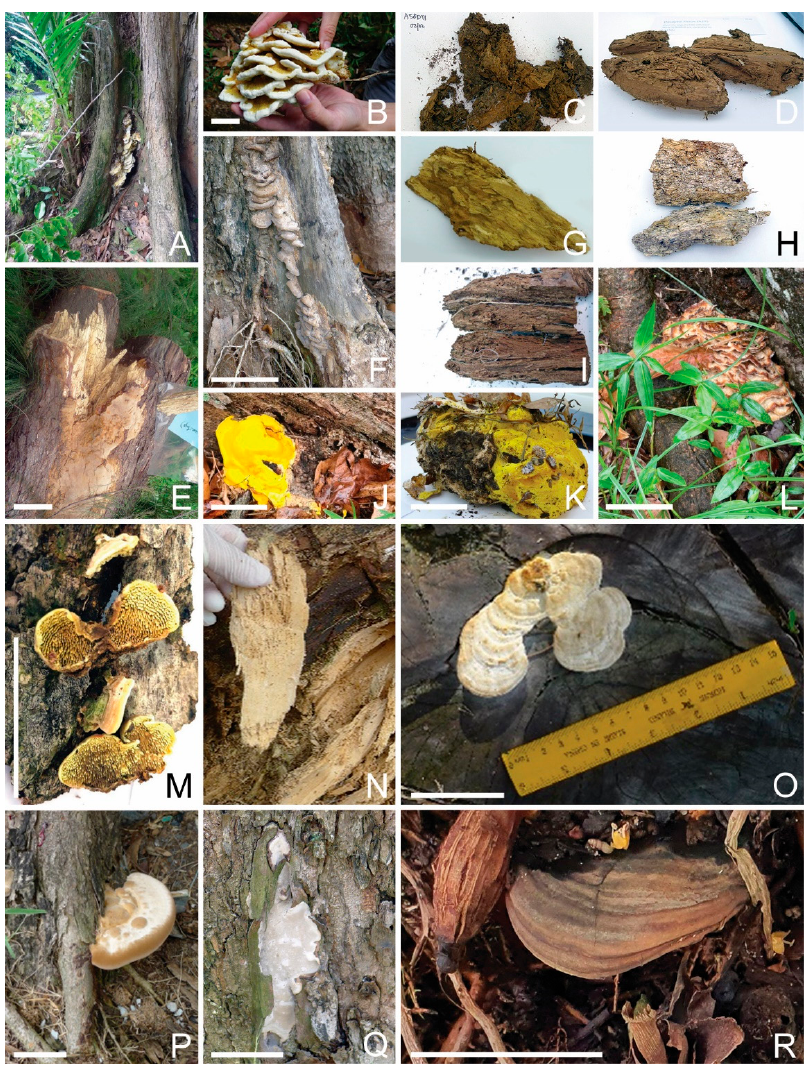
Figure 5. Other pathogenic fungi detected in Singapore urban trees. ( A ): An Angsana tree (A58) with Serpula similis fruiting bodies; ( B ): Serpula similis fruiting bodies (A58FB); ( C ): decayed wood from the same tree (A58DT1); ( D ): decayed Angsana wood dominated by Serpula similis from another tree (A34); ( E ): crust fungus Fomitiporia torreyae fruiting body on a Casuarina branch with decayed